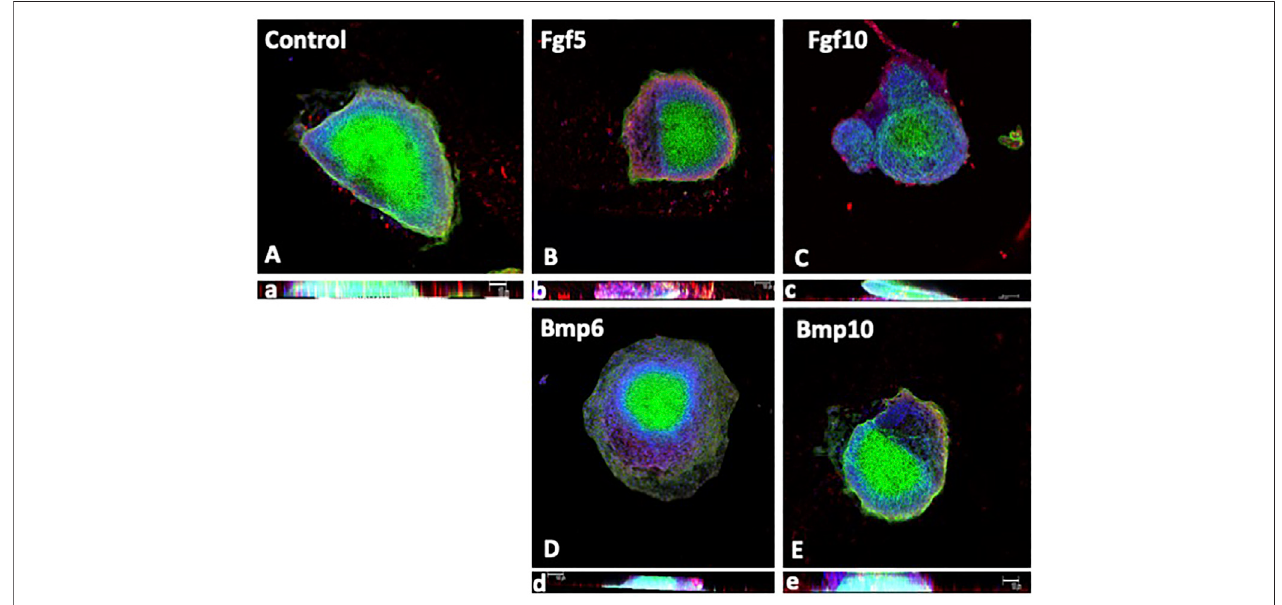
FIGURE7| Panels (A – E) ConfocalimagesofmouseE9.5PE/STexplantsaftercontrol (A) ,Fgf5 (B) ,Fgf10 (C) ,Bmp6 (D) andBmp10 (E) treatments,respectively. Note that treatment with Fgf5, Fgf10 and Bmp10 displays limited migration, similar to controls, while Bmp6 is signi fi cantly increased. Panels a – e represent Z-stack confocal views, respectively, where it can be observed that none of them display signs of